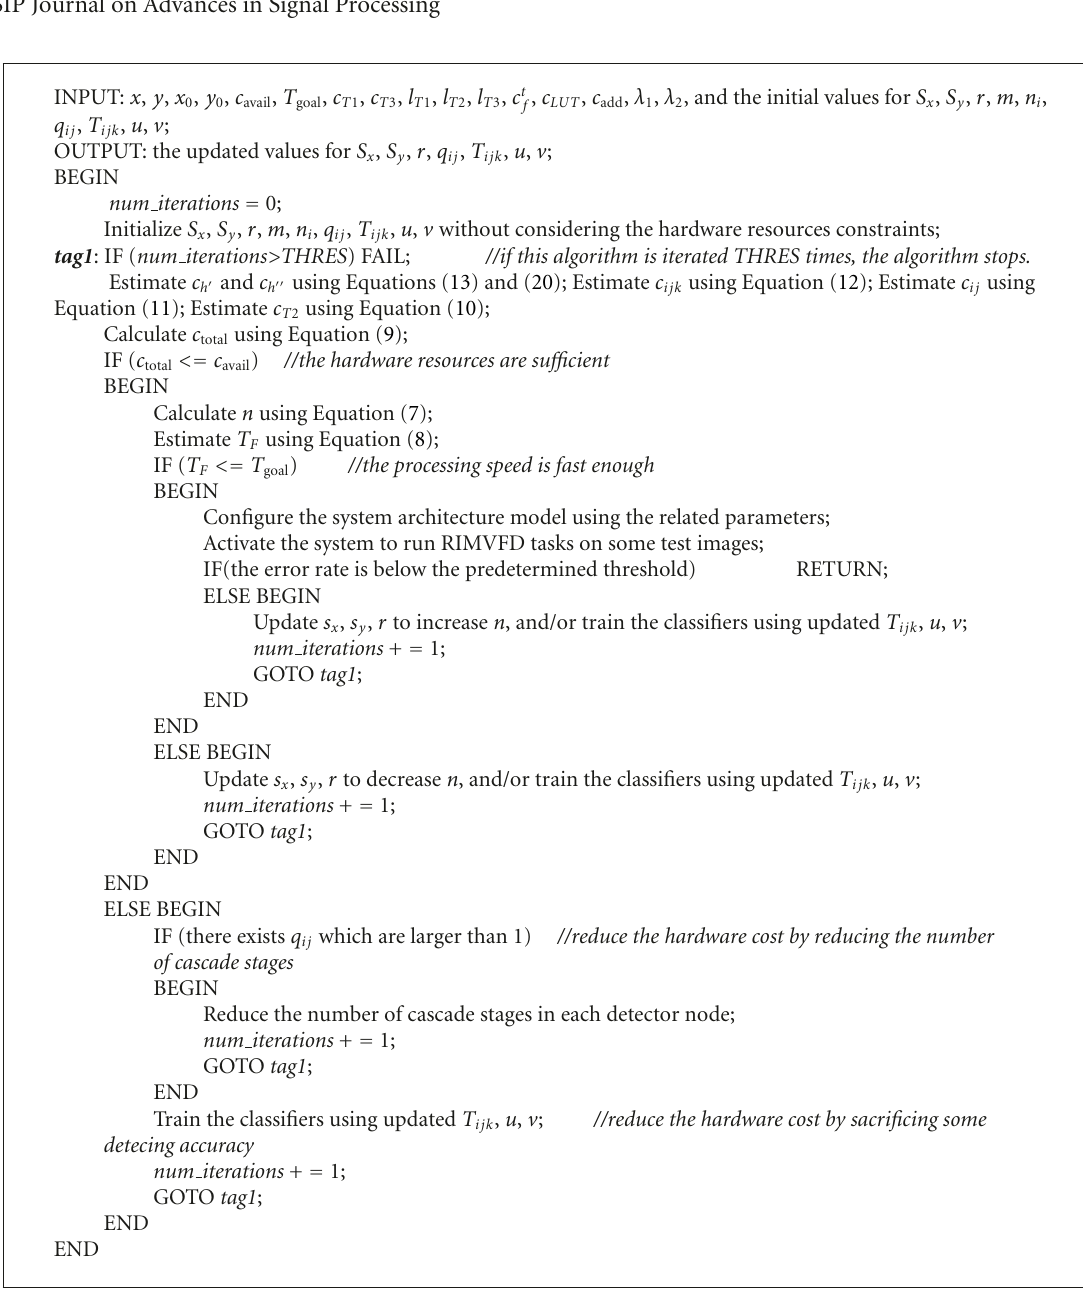
Algorithm 5: The design space exploration